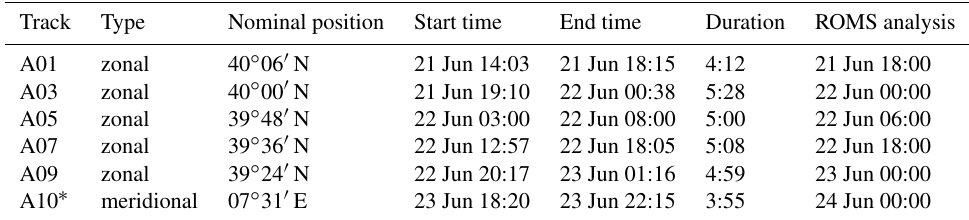
Figure 22. The sections along the A05 ScanFish track (cf. Fig. 5) at 40 ◦ 48 (cid:48) N: (a) the temperature recorded by the ScanFish, (b) the tem- perature predicted by ROMS, (c) the sea surface temperature SST, and (d) the mixed-layer depth evaluated from the ScanFish measurements and ROMS. No interpolation was used for the contour plots. Table 3. The timing and nominal positions of the ScanFish tracks considered in this study (cf. Fig. 5). The ROMS analysis determines the instant of the model output which was used for comparison. Track Type Nominal position Start time End time Duration ROMS